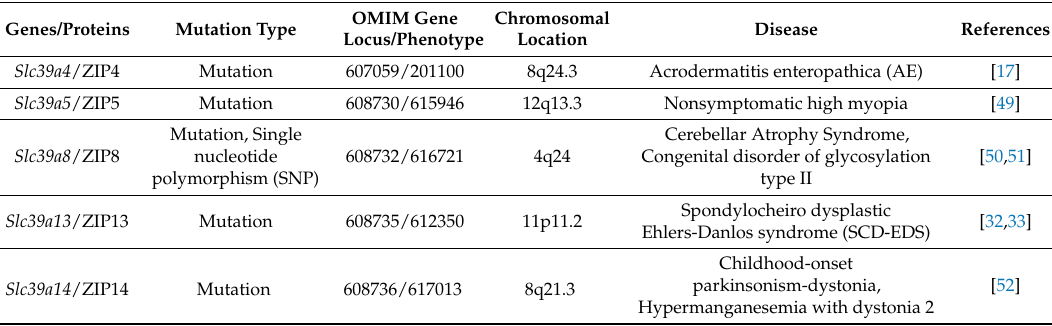
Table 2. Hereditary human diseases of SLC39A/ZIP